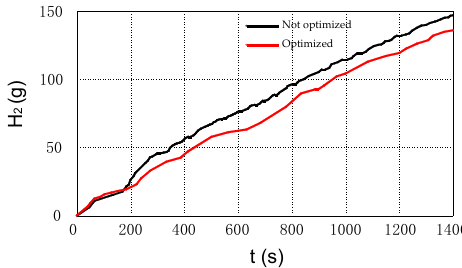
Figure 21. Hydrogen consumption during the UDDS drive cycle. Table 8. Comparison of the simulation results before and after the optimization.